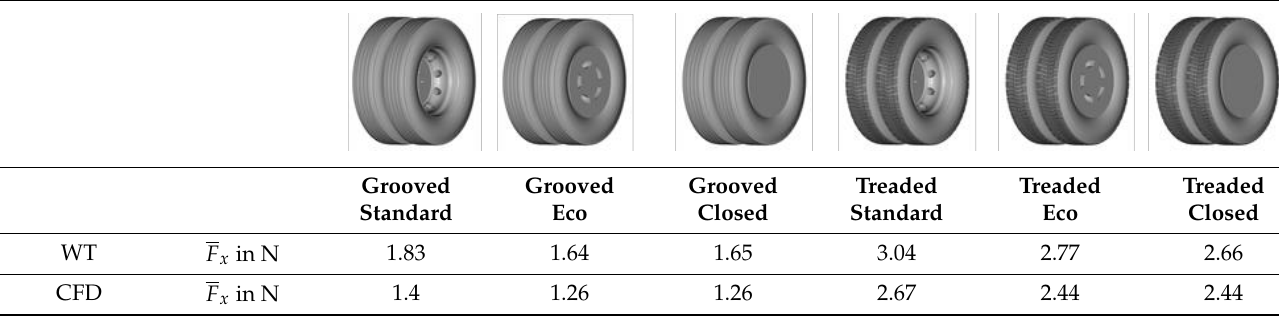
wheel configurations.